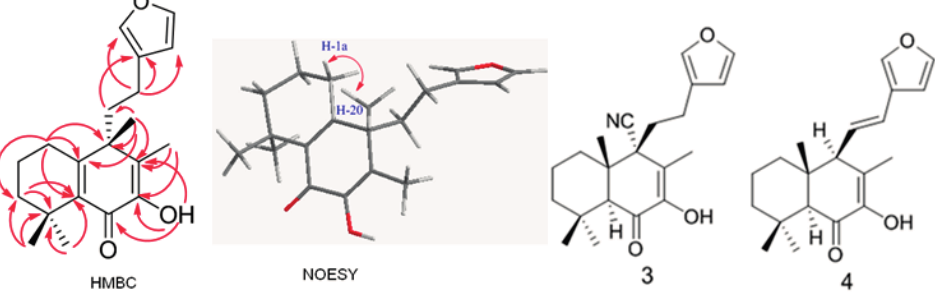
Figure 3. Selected HMBC and NOESY correlations of 1 , and structures of 3 and 4 .